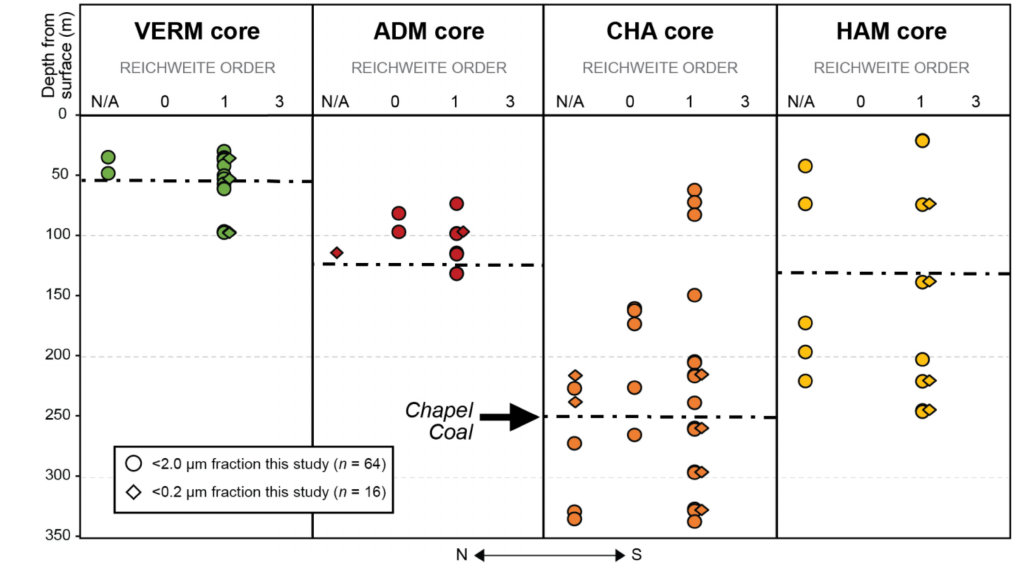
Figure 8. Reichweite Ordering values relative to stratigraphic position for each <2.0 µ m (circles) and <0.2 µ m (diamonds) equivalent spherical diameter clay-sized fraction of paleosol samples from the the Materials Service Corps #F-72-8 (VERM; green; <2.0 µ m, n = 13; <0.2 µ m. n = 4), Illinois State Geological Survey (ISGS)-Archer-Daniels-Midland, Borehole MMV-04B (ADM; red; <2.0 µ m, n = 10; <0.2 µ m, n = 2), ISGS #1 City of Charleston (CHA; orange; <2.0 µ m, n = 20; <0.2 µ m, n = 6), and the American Coal Company Borehole 7510-20 (HAM; yellow; <2.0 µ m, n = 10; <0.2 µ m, n = 4) cores associated with colored circles in of the IB map (Figure 2). The northernmost core is on the far left and the southernmost core is on the far right. The Chapel Coal (black dashed lines) is delineated for reference in each core to demonstrate stratigraphic control. Samples classified as N/A did not have any noticeable interstratification of illite-smectite visible in XRD patterns and therefore could not provide any ordering or illitization information (see Tables 2 and 3 for tabulated Reichweite Ordering